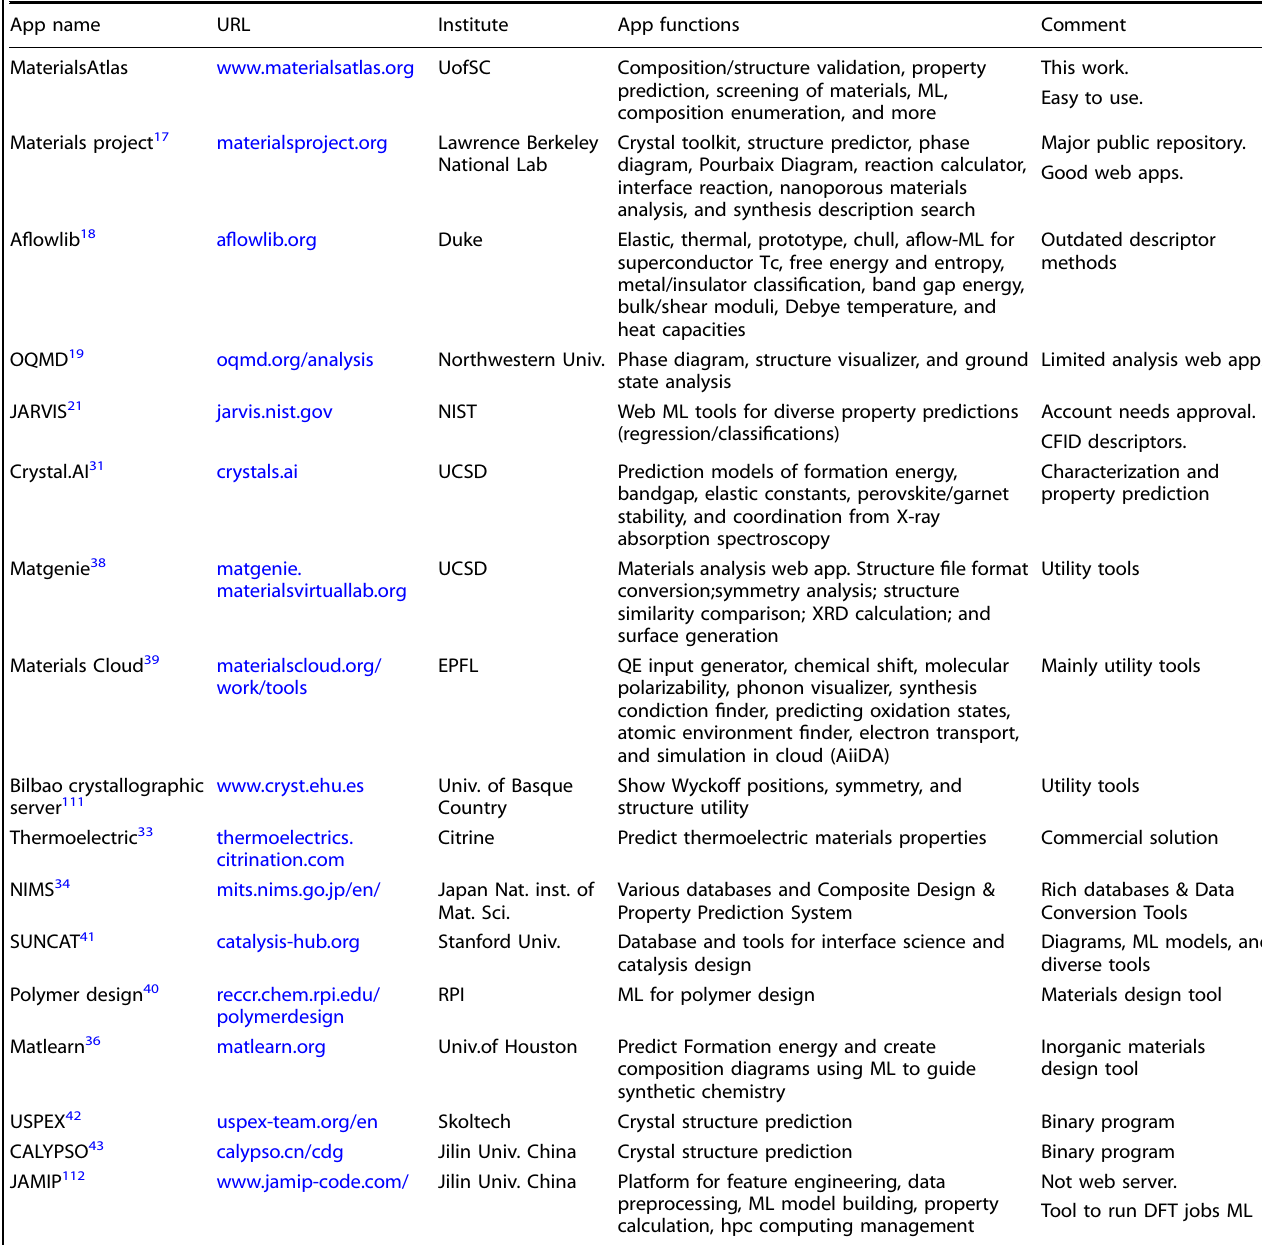
Table 1. Survey of current web apps for materials